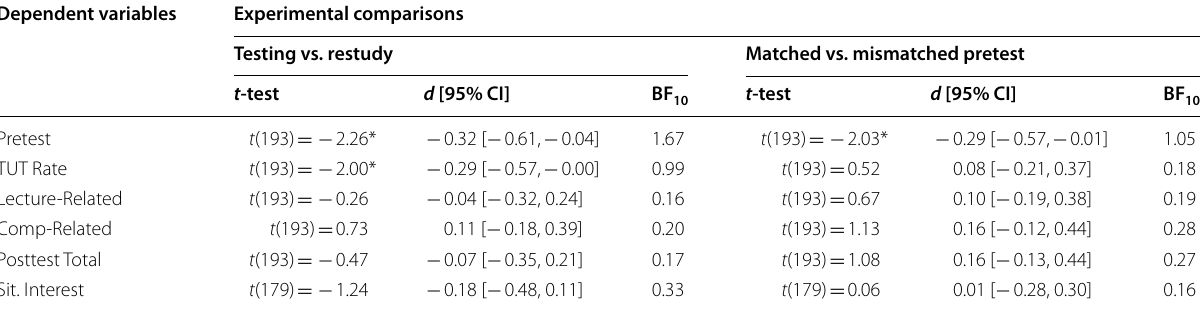
Table 2 Follow-up t -tests, Cohen’s d , and Bayes Factors (BF and Content-Matched Versus Content-Mismatched Pretest Conditions